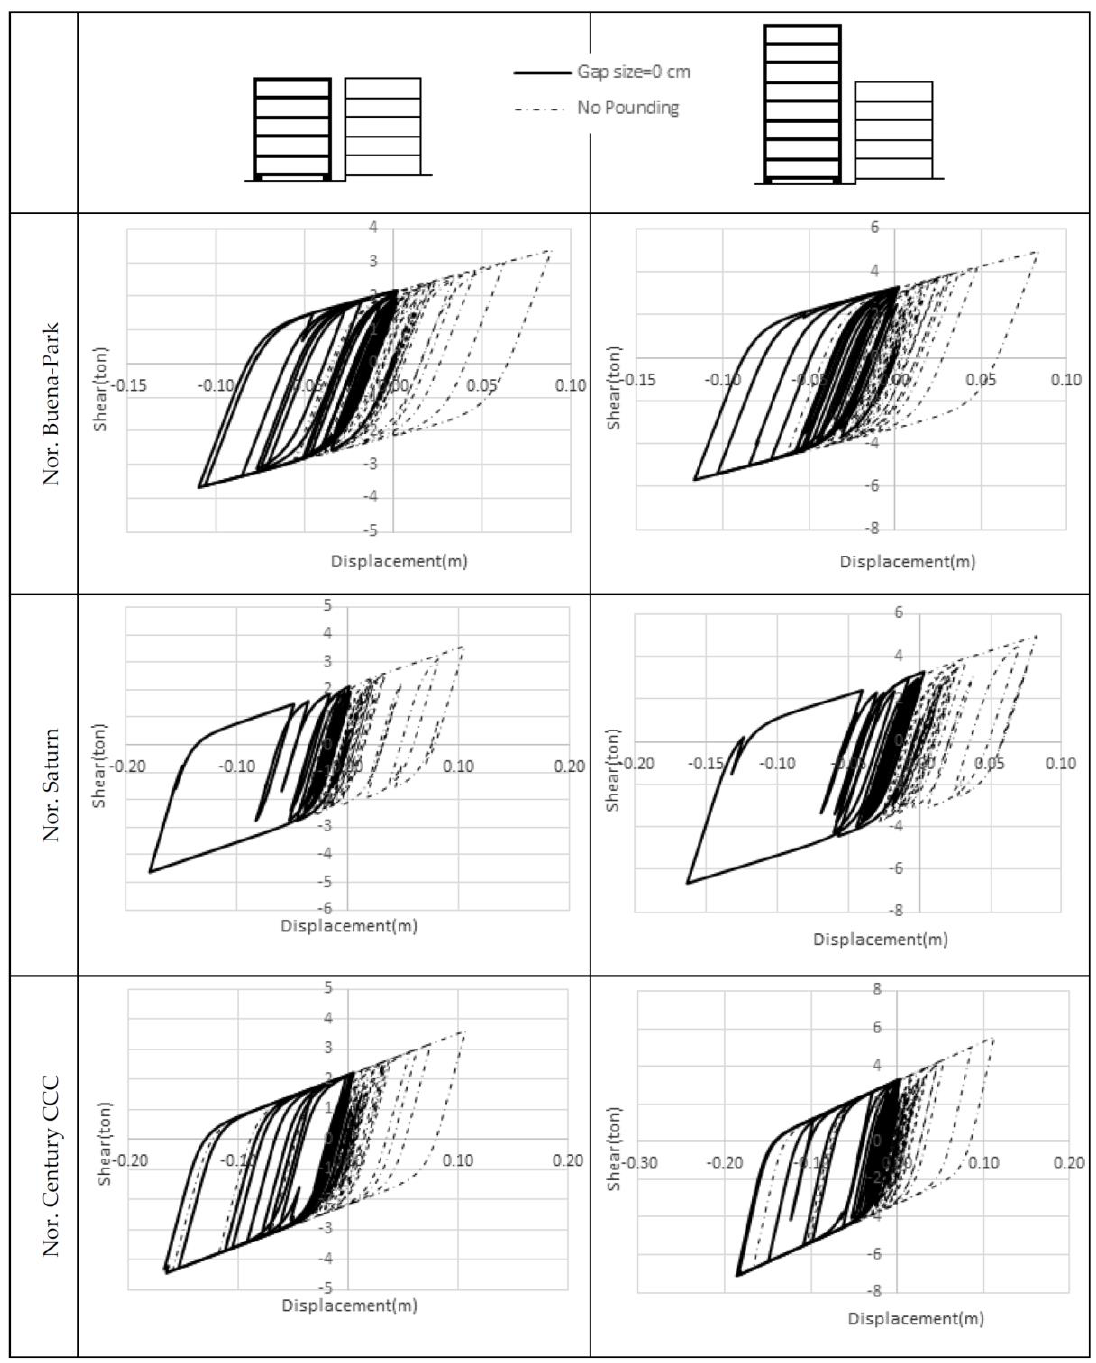
Figure 11. Hysteresis curves for isolators of the base-isolated building for pounding and no pounding cases during the Northridge earthquake (stations: Buena-Park, Saturn Street School, and Century CCC).